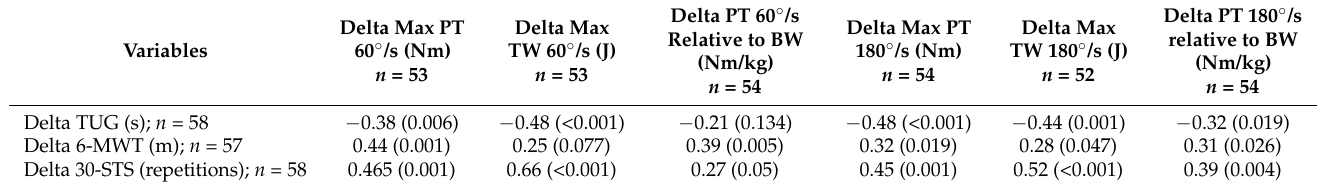
Table 4. Correlations between delta MS and delta PF parameters of the study total sample in the mid- to late-postoperative period after